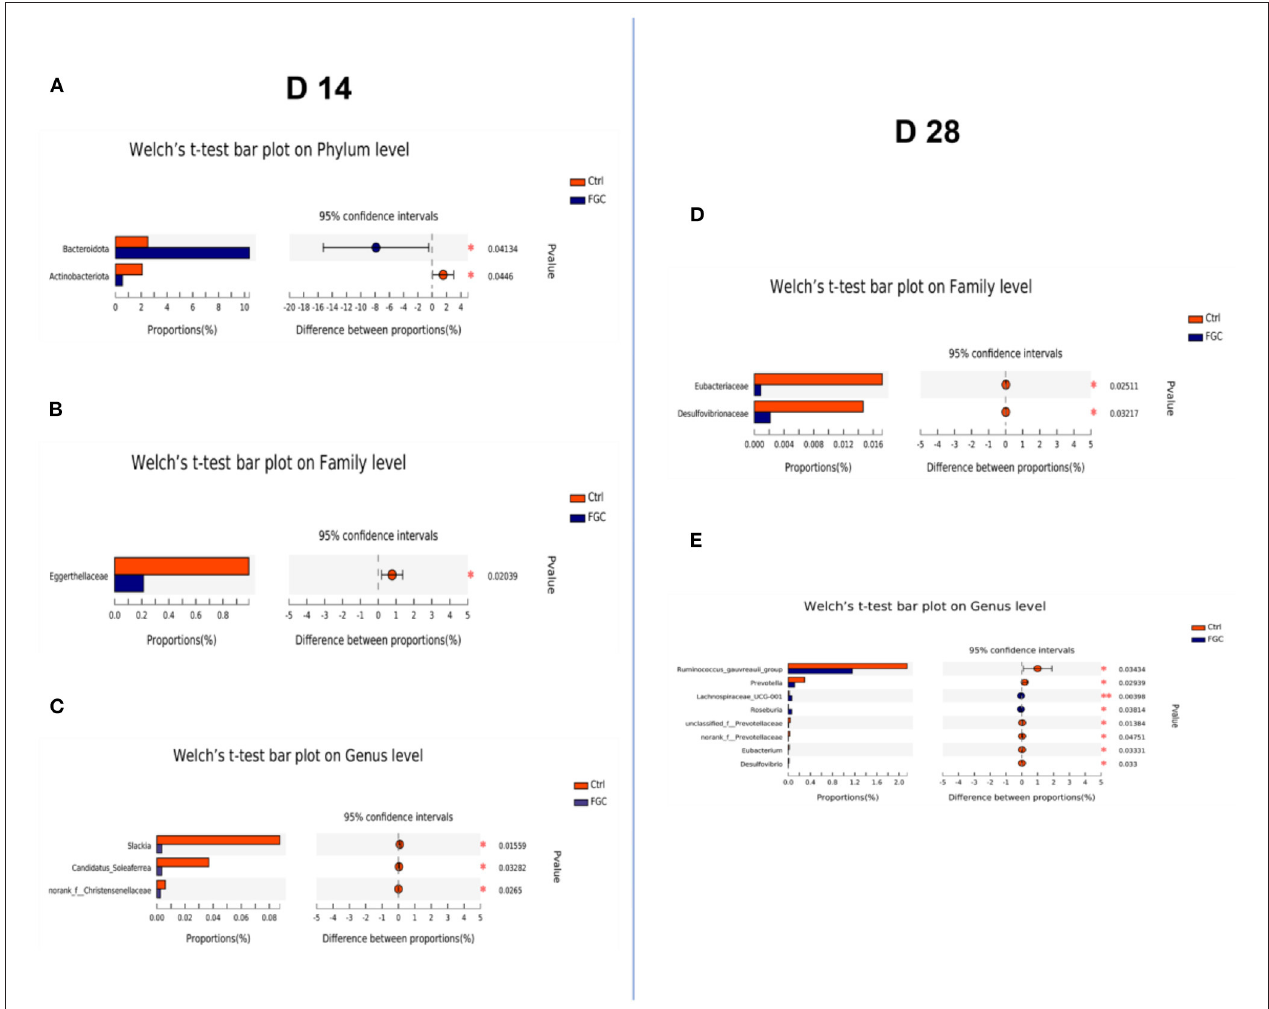
FIGURE 8 | Histogram of fecal microbial community differences. (A–C) Differences in fecal microbiota of 14d-piglets at phylum, family, and genus levels. (D,E) Differences in the fecal microbiota of 28d-piglets at family and genus levels. Ctrl, corn-soybean basal diet; FGC, corn-soybean basal diet with 2,000 mg/kg ferrous glycine chelate. N =